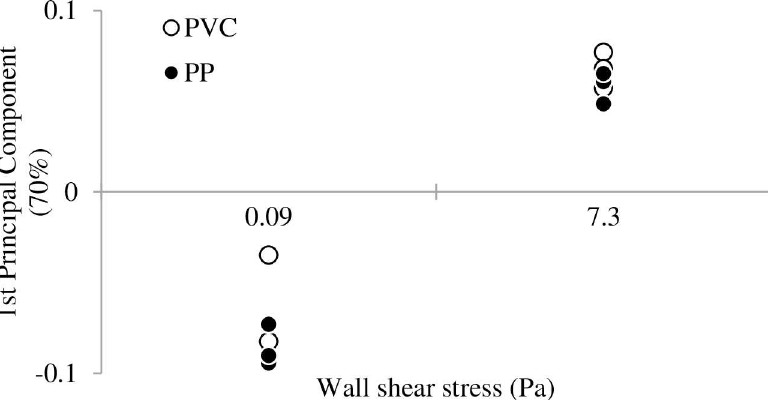
Fig 5. Results of the microbial community characterization for Phase 3, material test. Principal Component plot performed on the bacterial communitiesharvestedon slides of both PP and PVC obtainedfor materialtest (Mat experiment). As mentioned in Table 2, three slides of PP and three slides of PVC were characterized per reactor. One slide is missing (PVC, 0.09 Pa) becausethe DNA extraction did not succeed, hencetwo replicates are representedon the plot. Euclidiandistancesbetween points are proportional to geneticdifferencesbetweencommunities.